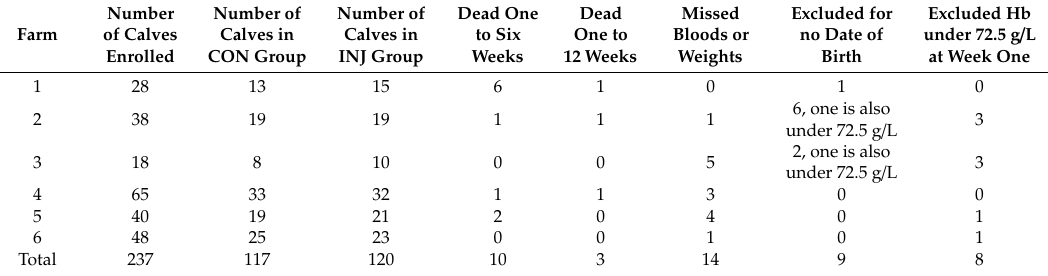
Table A1. Overall numbers of calves enrolled on each farm and in each treatment group, control (CON) and treatment (INJ) number of calves lost pre-weaning, number of calves excluded, and number of blood samples lost, and weights missed. Mathematical means are